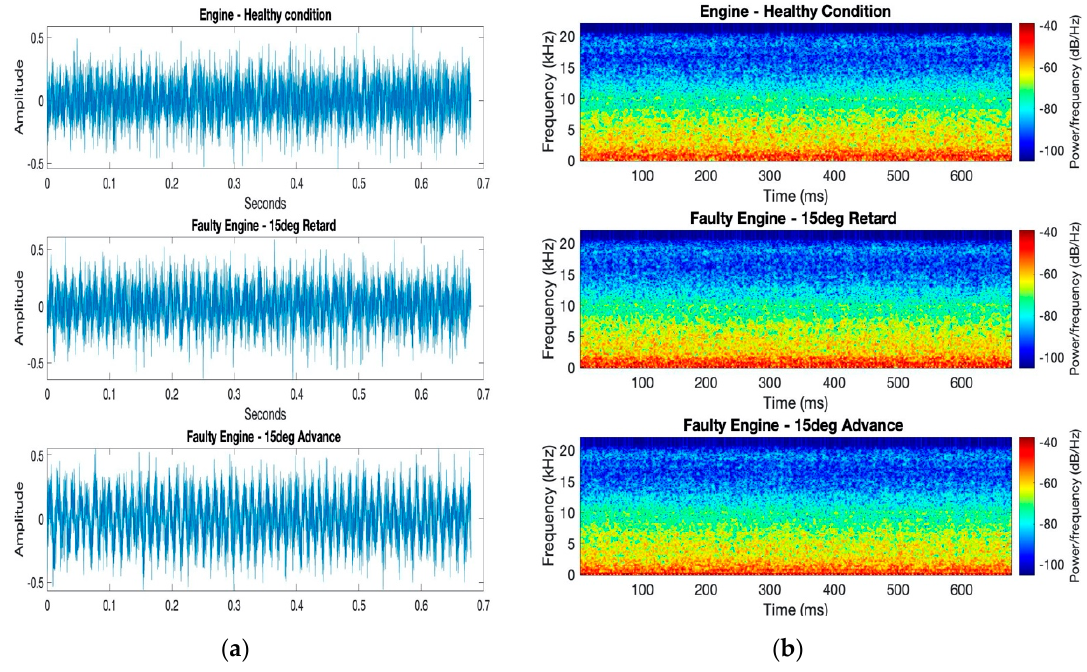
Figure 3. Ignition timing variation—healthy and faulty: ( a ) signals; and ( b ) spectrogram.